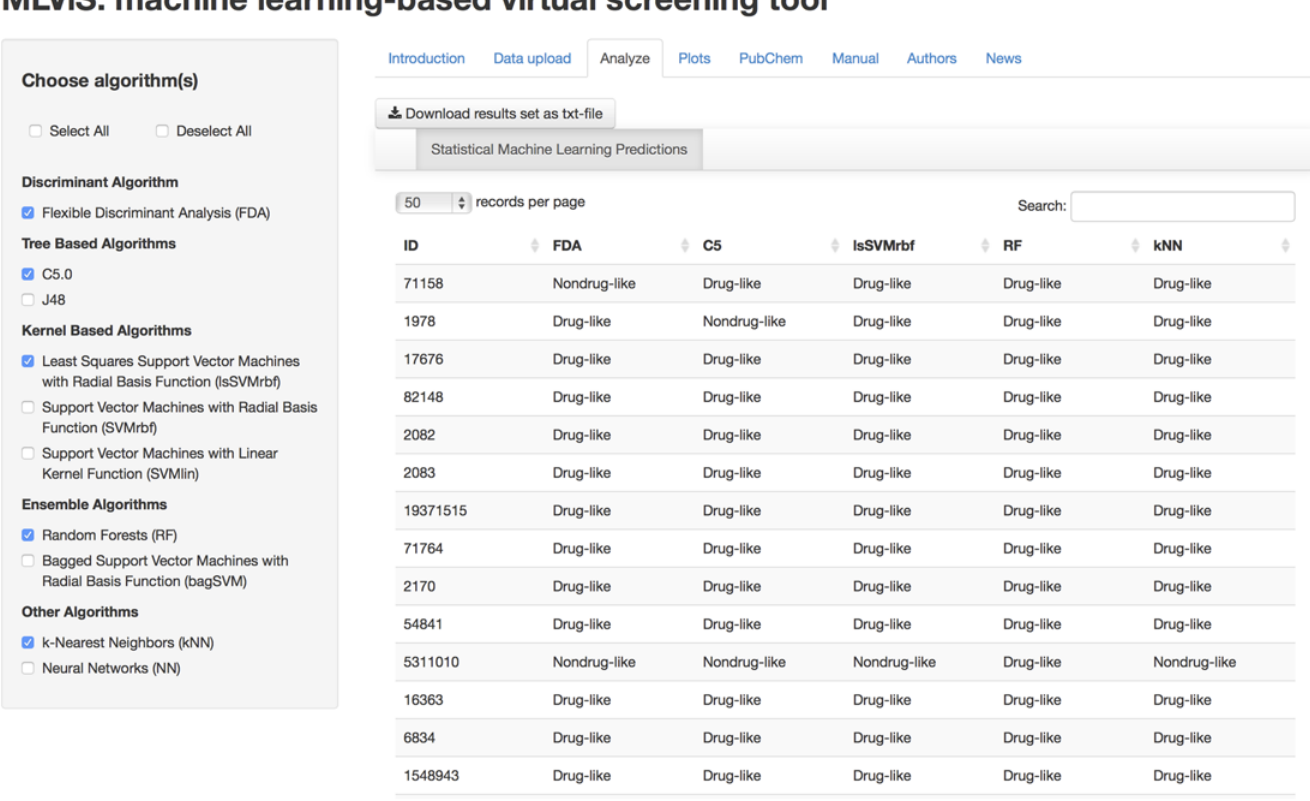
Fig 4. Analyze tab of the MLViS web-tool. A classification task can be performed using the statistical machine learning